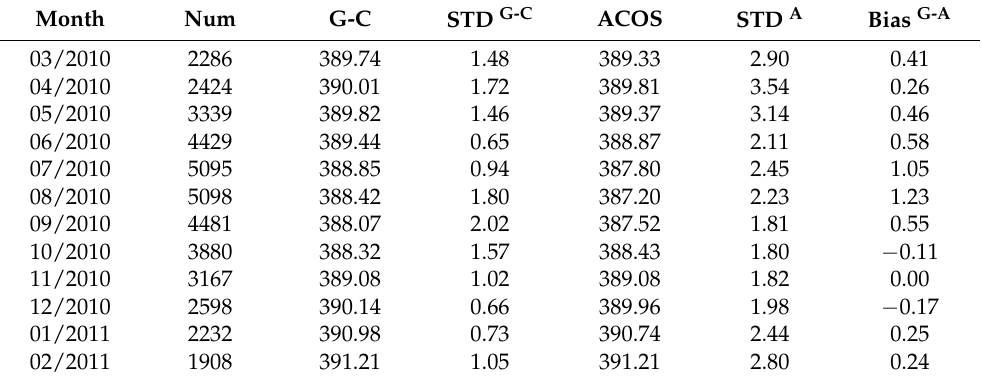
Table 2. Statistics of the number of XCO 2 data (N), standard deviation (STD) and averaged biases (Bias) for GEOS-Chem (G-C), GOSAT/ACOS (G-A for GEOS-Chem − ACOS) over the global land